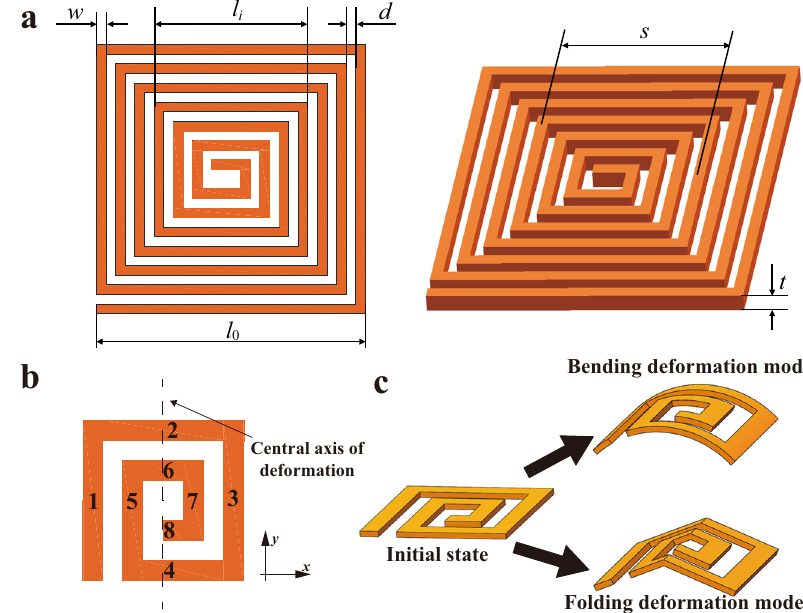
Fig. 2 Mechanical model of PSIFS. a Schematic of the basic structure parameters of coils in PSIFS. b Schematic of simpli fi ed less-turn model. c Schematic of bending and folding deformation